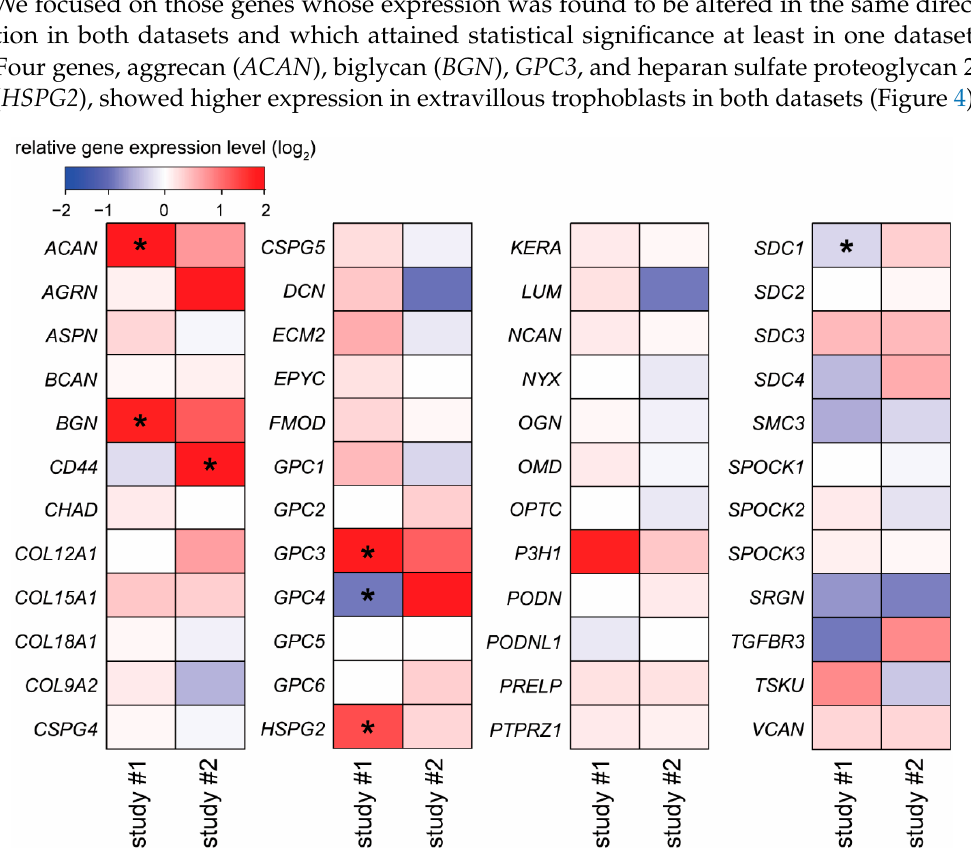
Figure 4. Differentially expressed proteoglycan genes in invasive extravillous trophoblast cells compared to villous cytotrophoblast cells. Microarray data from two independent GEO (study #1) [63] or ArrayExpress (study #2) [13] datasets were reanalyzed. Color code depicts log 2 gene expression ratios. Red indicates higher gene expression in extravillous trophoblasts, while blue depicts higher gene expression in villous cytotrophoblasts. Stars show significant differences.